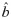
Group differences between patients with schizophrenia and control subjects in the HBM.The HBMc parameter b^ (A) and the relation b^/b^S (B). (C): Differences in b^S/b˜^S and p^SS*. The raw data together with the median (colored diamonds) and 25%- and 75%-quantiles are shown. All p-values of a two-sided Wilcoxon test were below.1.